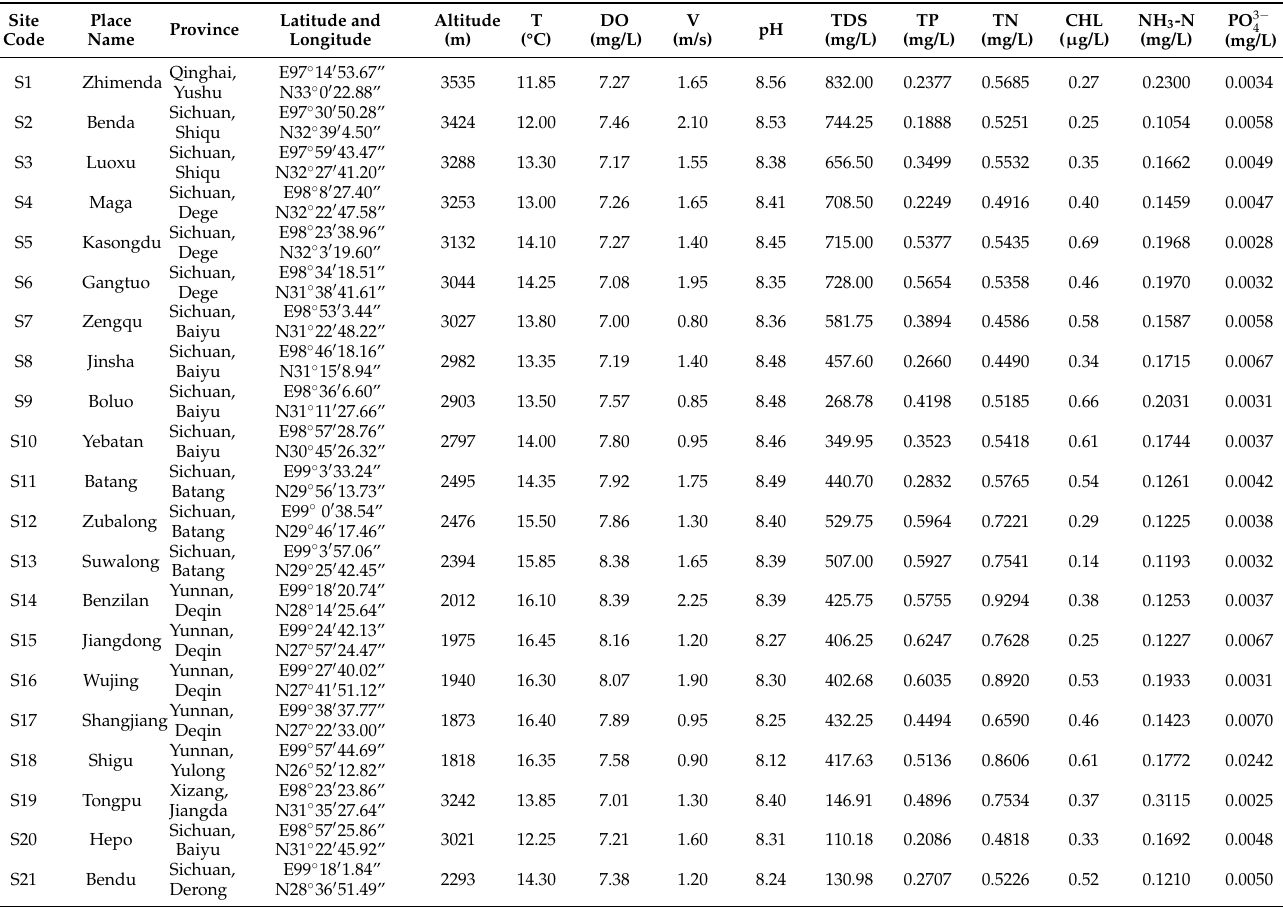
Table 1. Spatial parameters and water quality of sampling sites in the upper reaches of the Jinsha